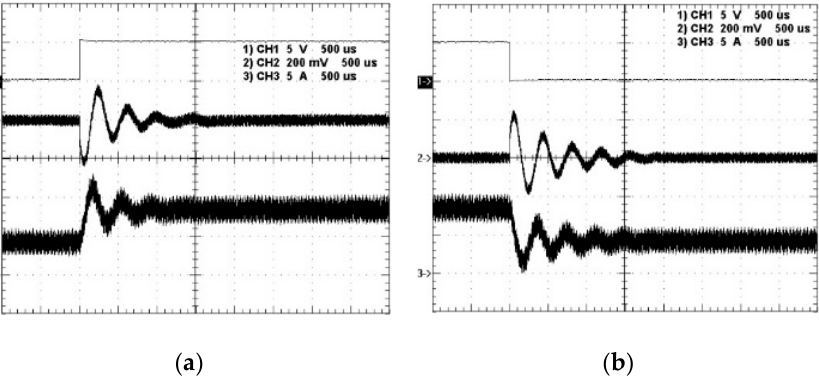
voltage; (3) inductor current, due to ( a ) from 25% to 75%; ( b ) from 75% to 25%.